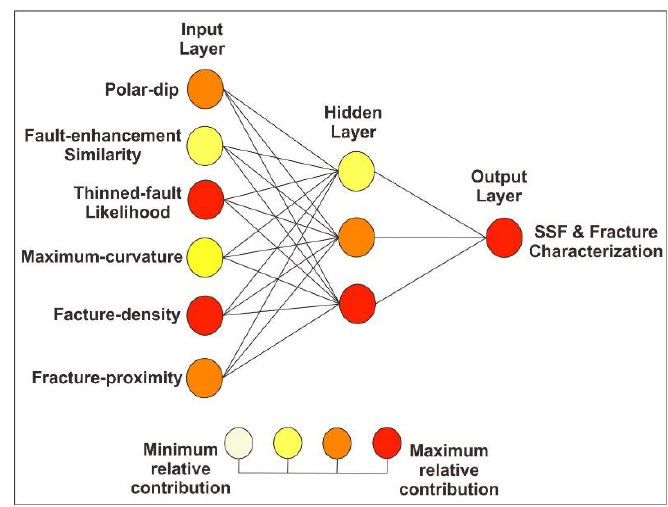
Figure 11. The ANN–UVQ (unsupervised vector quantization) network that was comprised of three layers of 10 nodes. The input layer had 6 nodes, the hidden layer had 3 nodes, and the output layer had 1 node. The colored legend shows the relative importance of every shortlisted attribute as an input to compute an output.